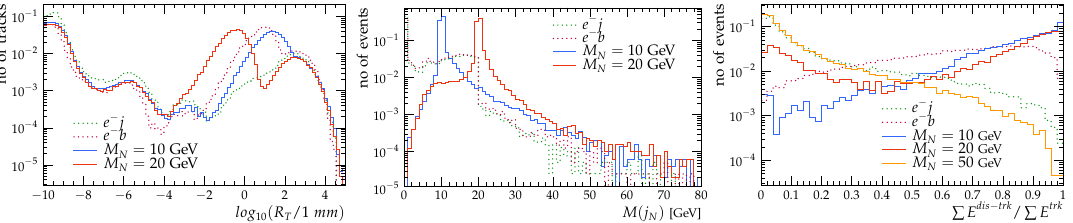
Figure 6 . Left panel: R T distribution of the tracks. Middle panel: invariant mass distribution of neutrino jet. Right panel: distribution of the summed energy ratio of the displaced tracks and all possible tracks associated to the displaced